Question: According to this chart, does the measure grow or shrink?
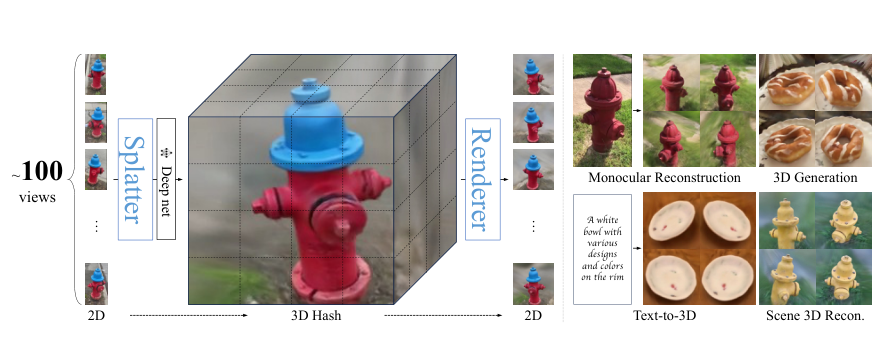
Answer: increasing